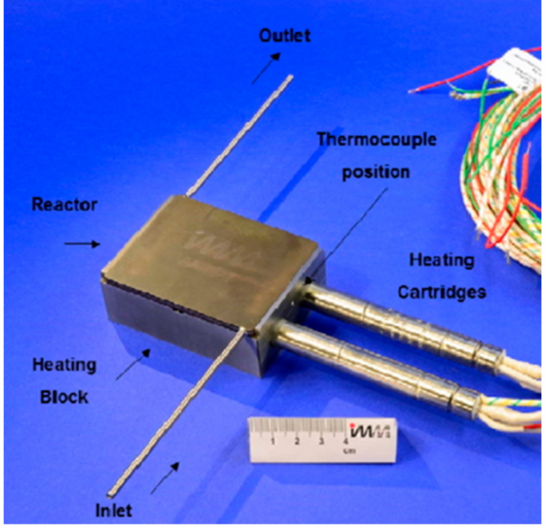
Figure 2. The experimental microchannel reactor with inlet and outlet piping, heating block, and cartridge heaters. Reproduced with permission from S. Chiuta, R.C. Everson, H.W.J.P. Neomagus, D.G. Bessarabov, International Journal of Hydrogen Energy; published by Elsevier, 2015